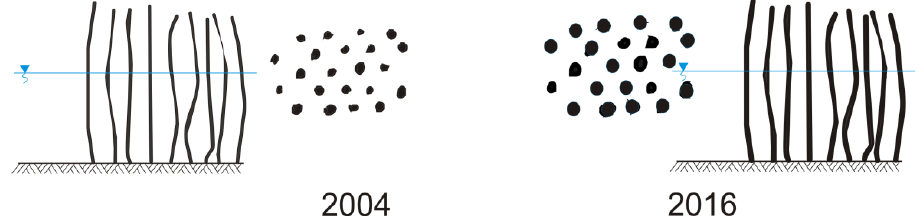
Figure 3. Simulation diagram of the vegetation grown on the plot during 12 years of observation.